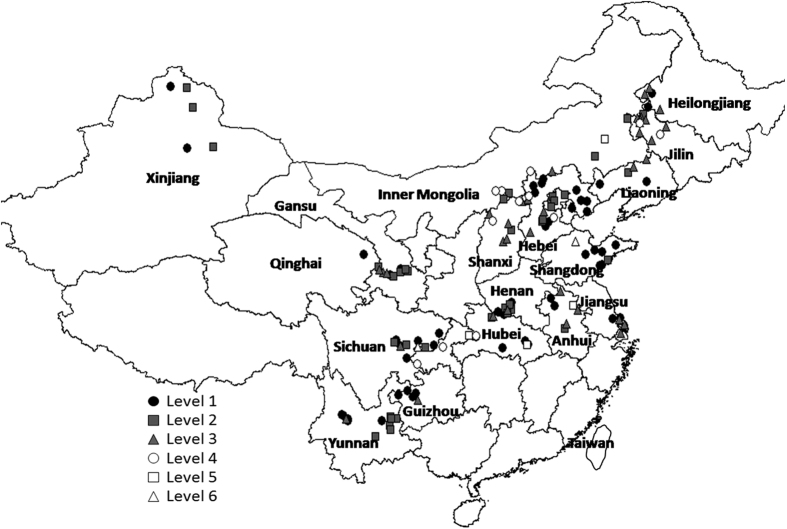
Map of classification of soil available phosphorus (AP) in food legumes growing areas, Greater China.Created by DIVA_GIS (v7.5) software. Hijmans, R.J., Guarino, L., Mathur P. DIVA-GIS. Version. 7.5. http://www.diva-gis.org/ (2012) Data of access: 05/07/2015.